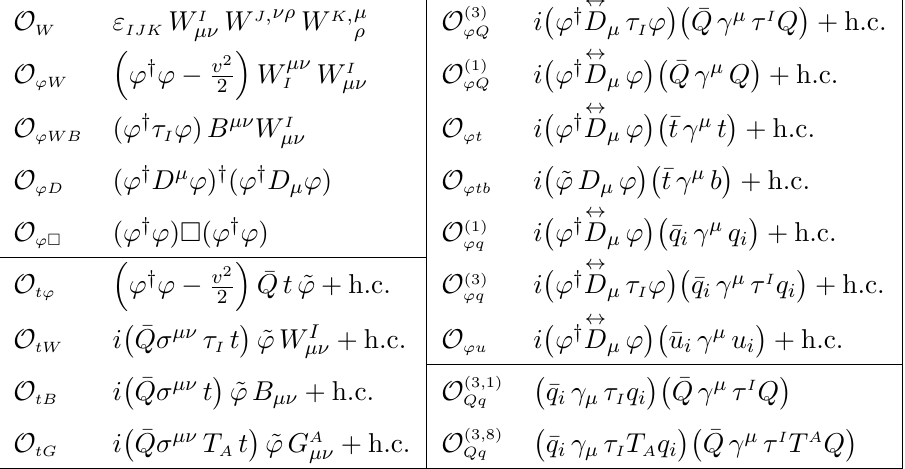
Table 1 . Dim-6 operators relevant for the tZj and tHj processes. The (cid:12)rst set corresponds to bosonic operators, then two-fermion ones, and, (cid:12)nally, four fermion